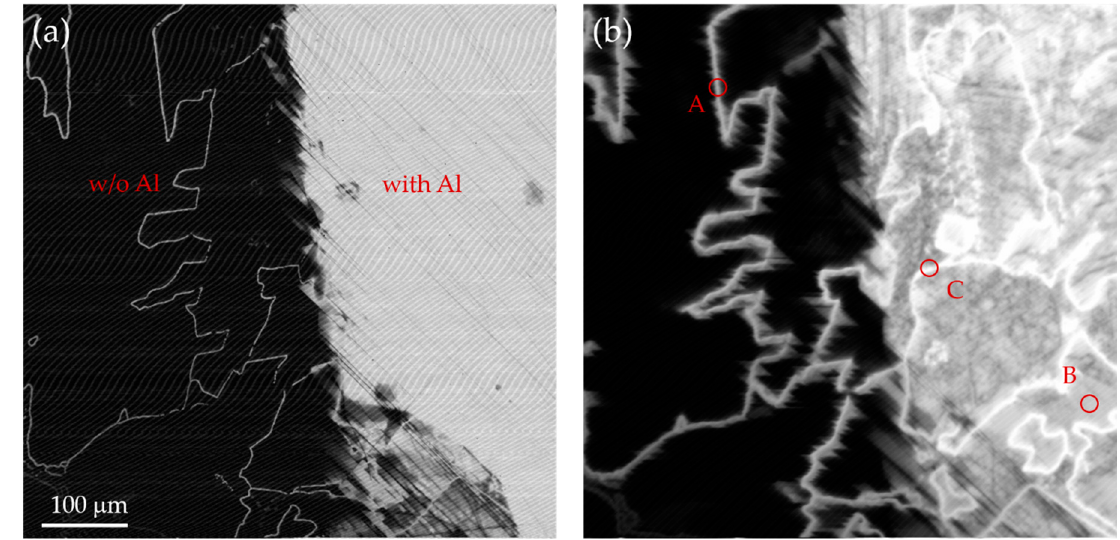
Figure 6. Comparison of EBIC images taken at 5 kV ( a ) and 20 kV ( b ). Table 2. Beam parameters and collected EBIC currents from different regions.